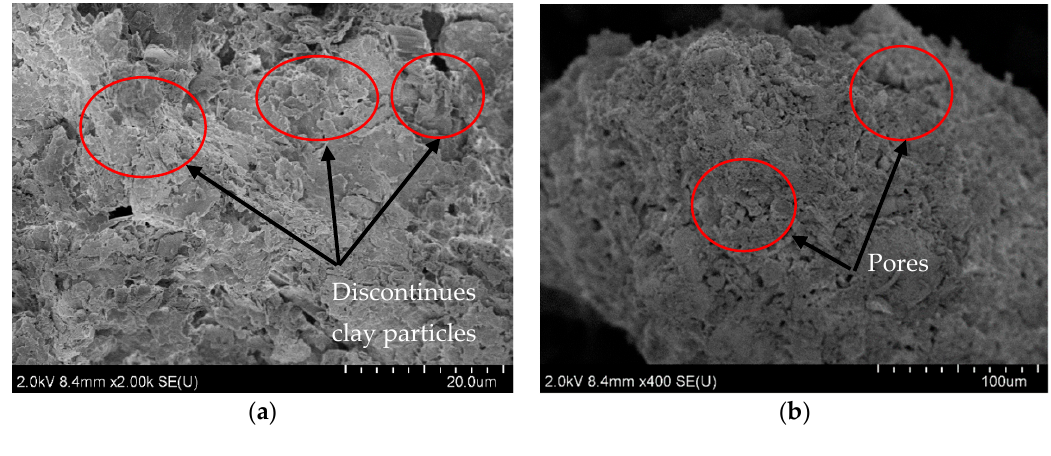
Figure 6. FESEM images for untreated soil.